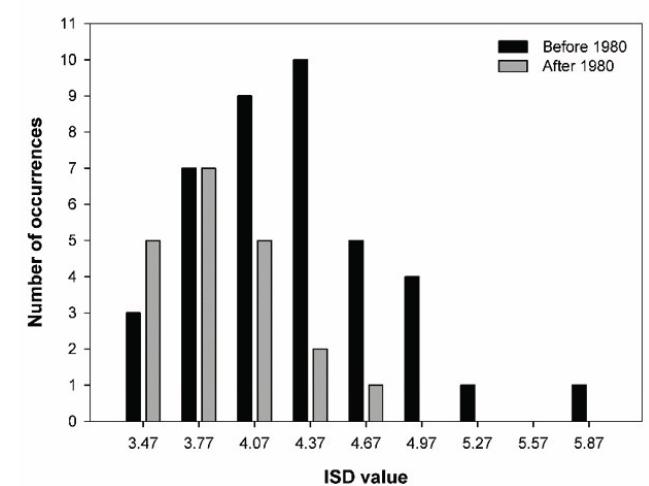
Figure 7. ISD frequency histogram representing roofs laid before 1980 and after